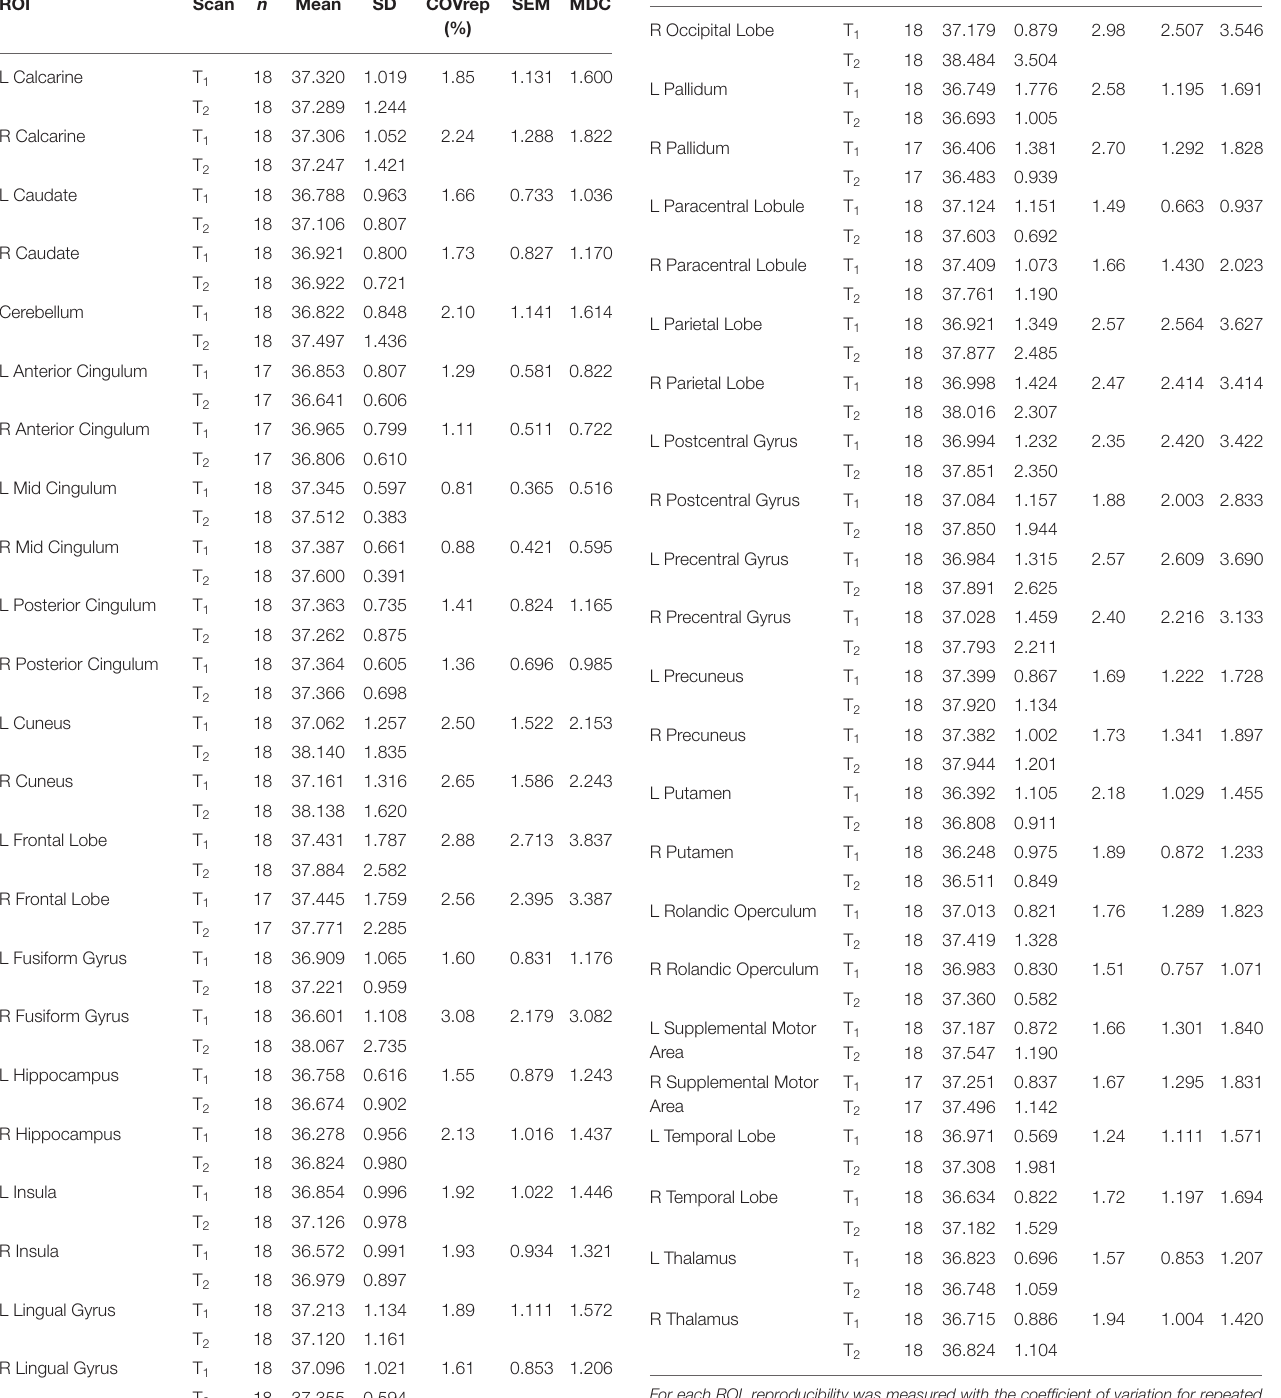
TABLE 2 | Mean MRSI-based brain temperature (T CRE ) in 47 ROIs for both time points time1 (T 1 ) and time2 (T 2 ), their standard deviations (SD), and corresponding reproducibility and reliability